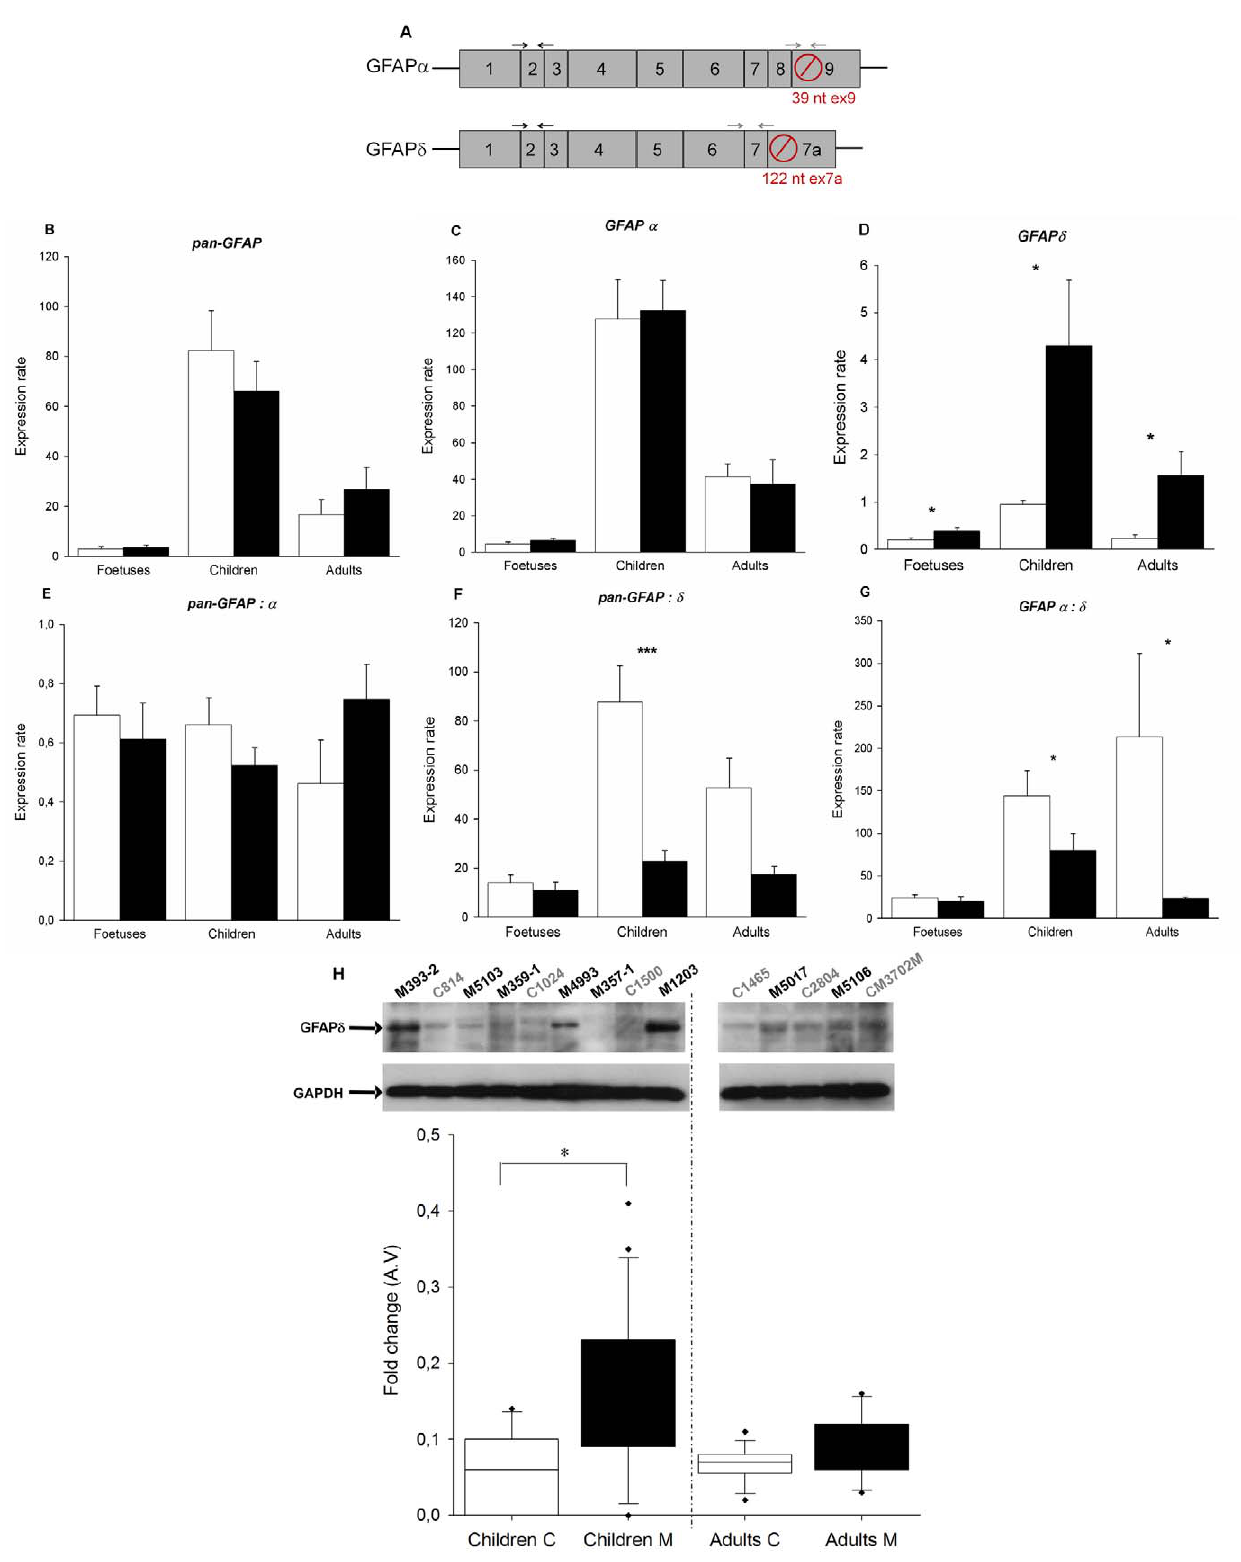
Figure 3. Study of the splice GFAP in eIF2B-mutated patients brains. A. Transcripts of human GFAP splice variants. The boxes represent the exons that are transcribed for the different isoforms. The termination codon, indicated by a blocked round circle, is located in exon 9 for GFAPalpha , and in exon 7a for GFAPdelta . The black and grey arrows represent respectively common primers between GFAPalpha and GFAPdelt a (forward primer between the exons 1 and 2, reverse primer between exons 2 and 3), and specific primers for each isoforms (forward primer between the exons 8 and 9, reverse primer in the exon 9 for the GFAPalph a isoform, forward primer in the exon 6, reverse primer between the exons 7 and 7a for the GFAPdelt a